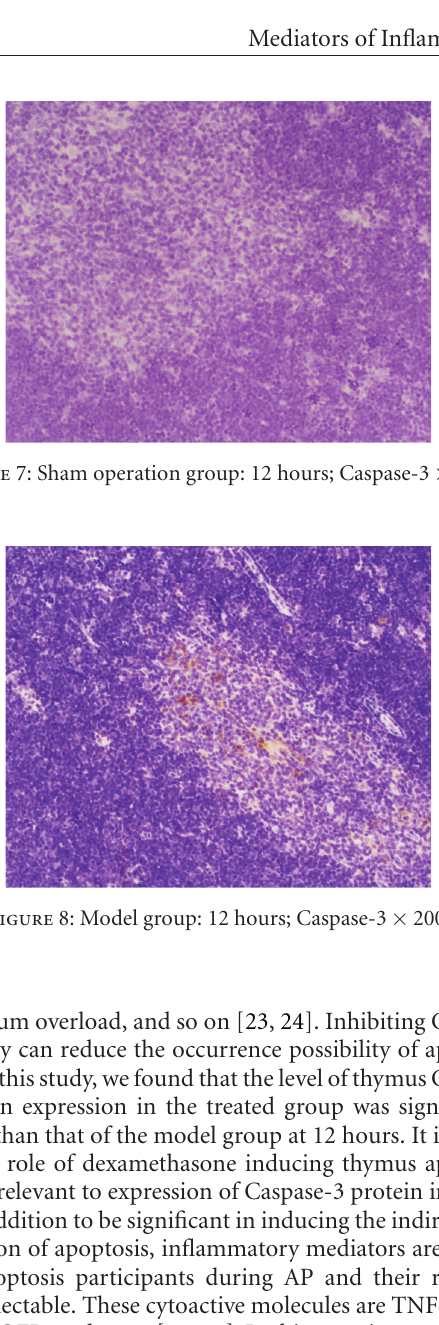
Table 7: Comparision of Caspase-3 protein of the thymus ( M ( Q R )). Group 3h 6h 12h Sham operation group 0.00 (0.00)